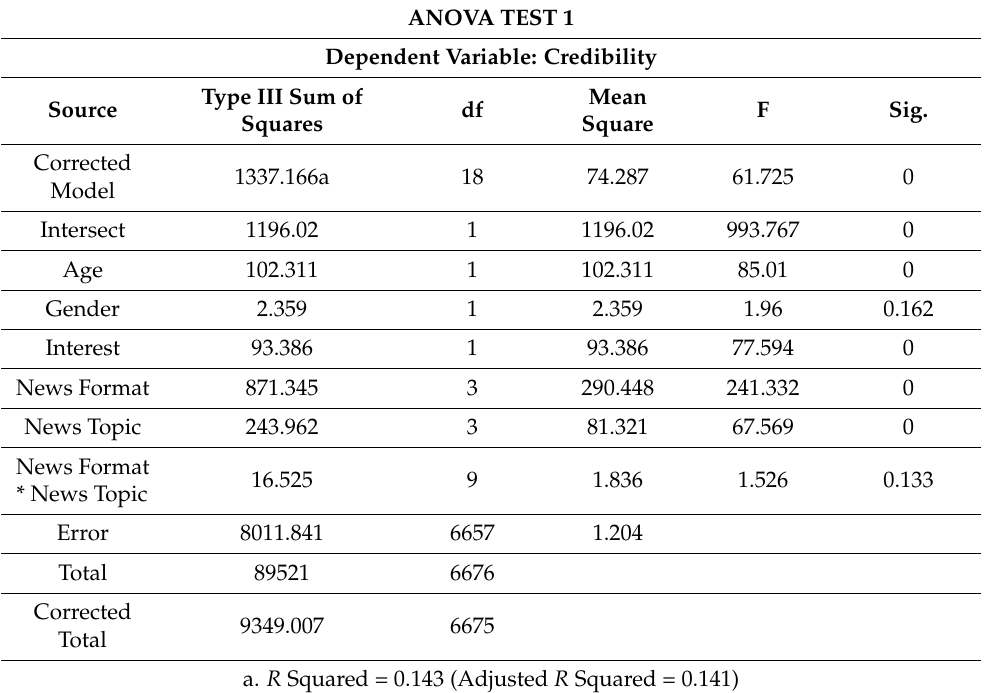
Table 3. ANOVA test. Credibility as dependent